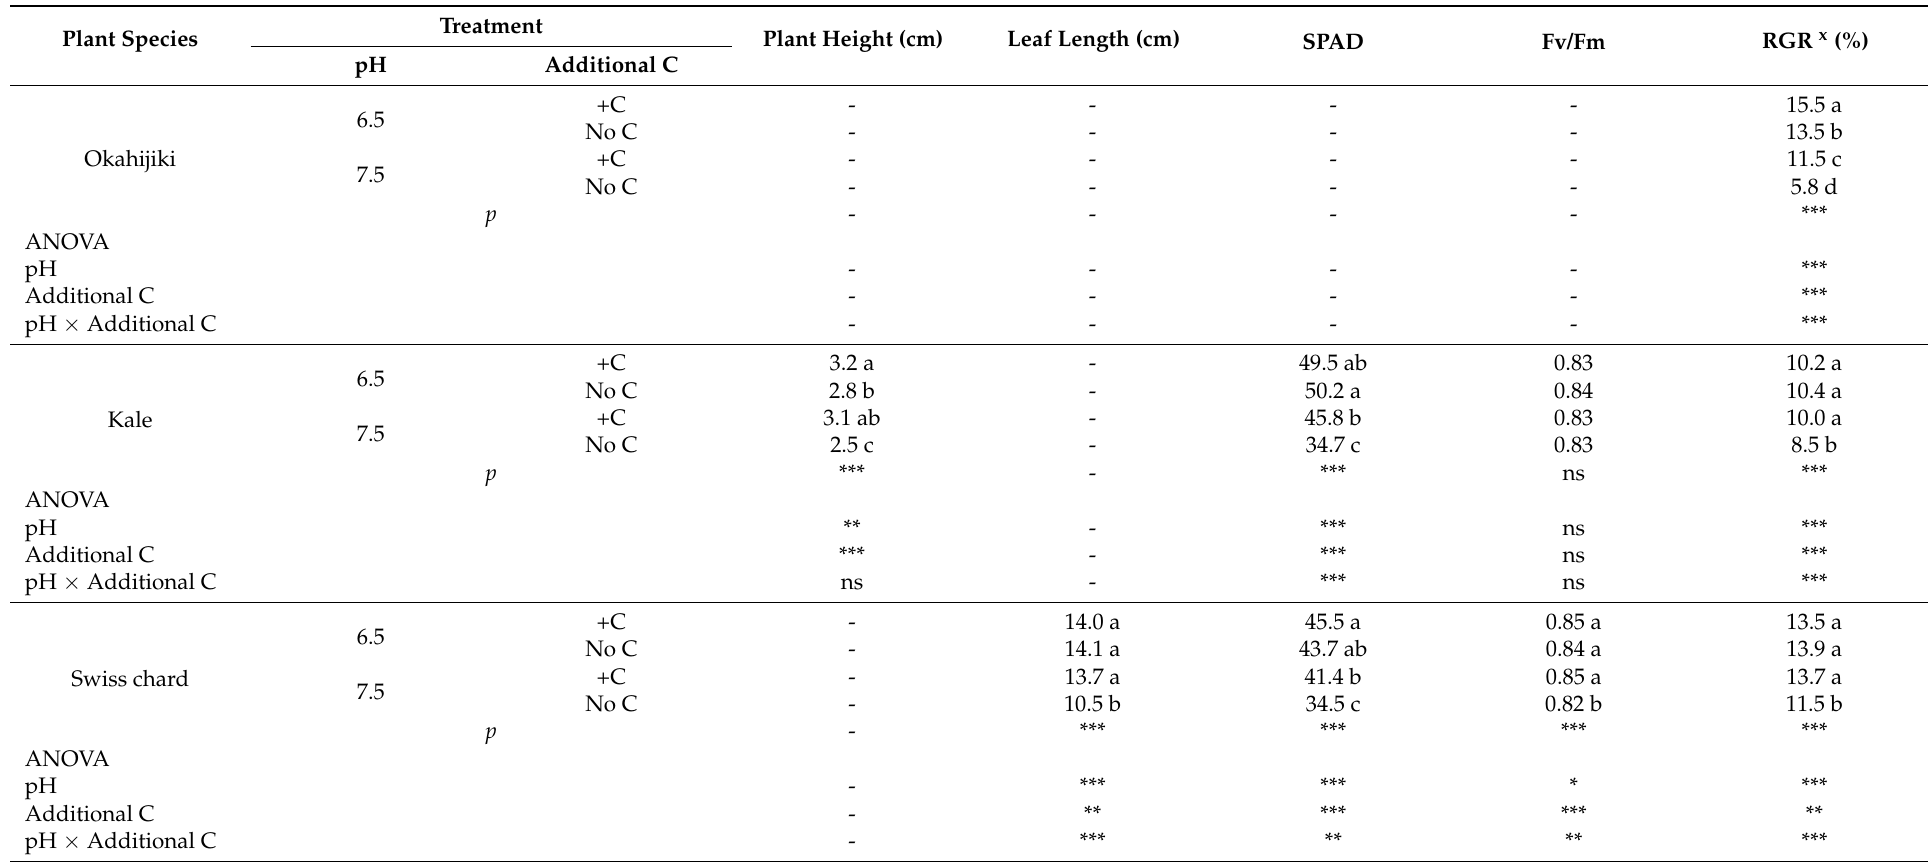
Table 5. Plant growth parameters of okahijiki, kale, and Swiss chard in aquaponics under two pH levels with or without additional C in the second harvest. Plant Species